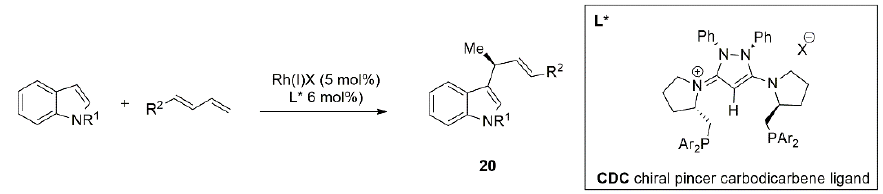
Figure 13 . Asymmetric CDC-Rh(III) catalyzed diene hydroarylation.